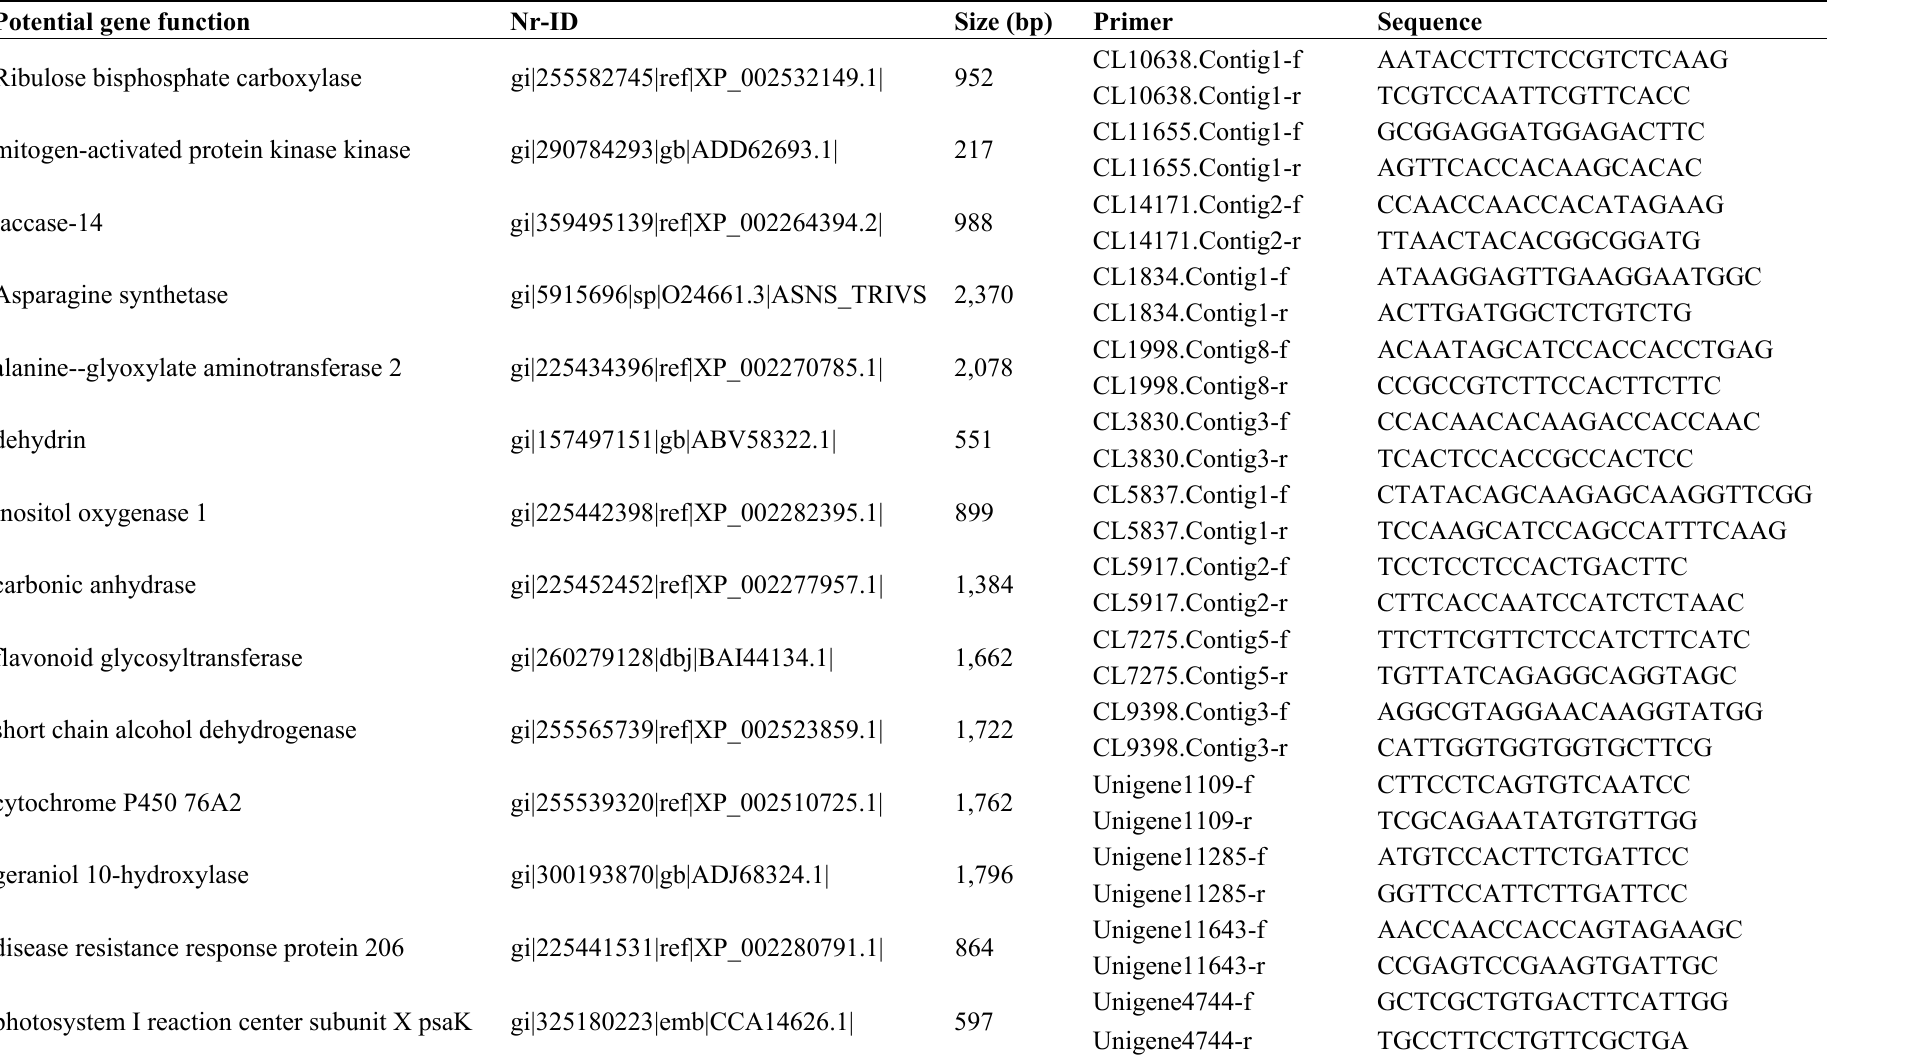
Table 4. Primers of quantitative RT-PCR analysis of candidate drought response genes. “-f” represents forward primers, and “-r” represents reverse